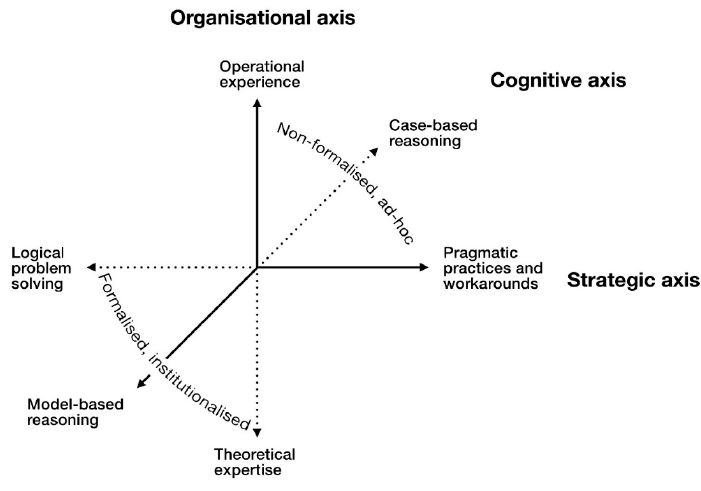
Figure 1. Sensework, from [47].